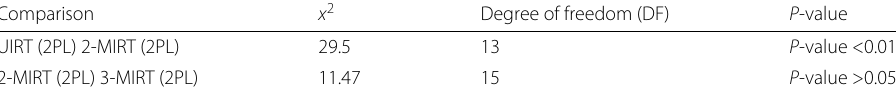
Table 10 Chi-square tests comparing the fit of UIRT (2PL) and MIRT (2PL) models Comparison x 2 Degree of freedom (DF) P -value UIRT (2PL) 2-MIRT (2PL) 29.5 2-MIRT (2PL) 3-MIRT (2PL) 11.47